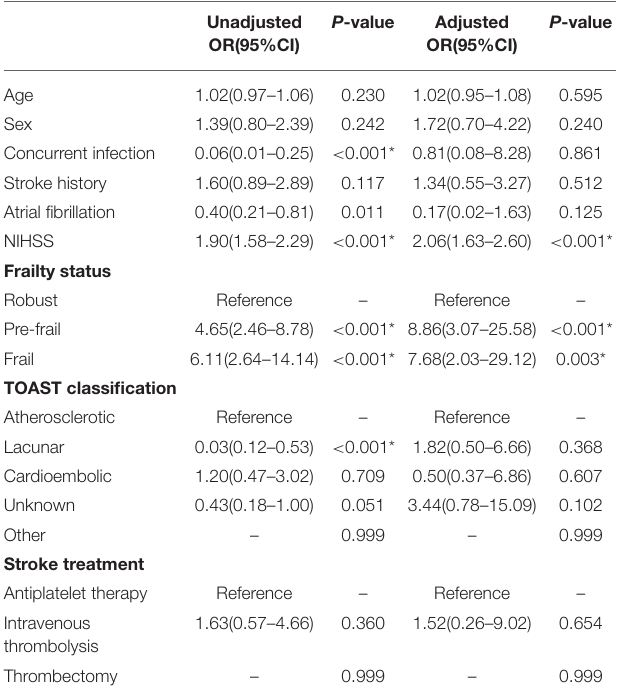
TABLE 6 | Logistic regression for a 28-day functional outcome for functional recovery